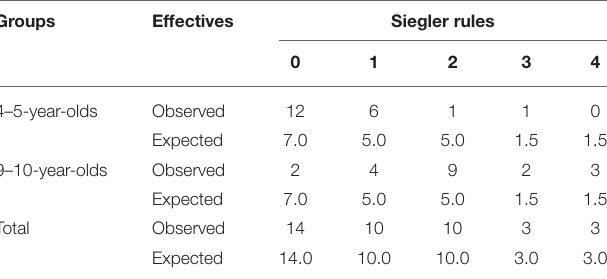
TABLE 1 | Observed and expected children’s classification according to Siegler